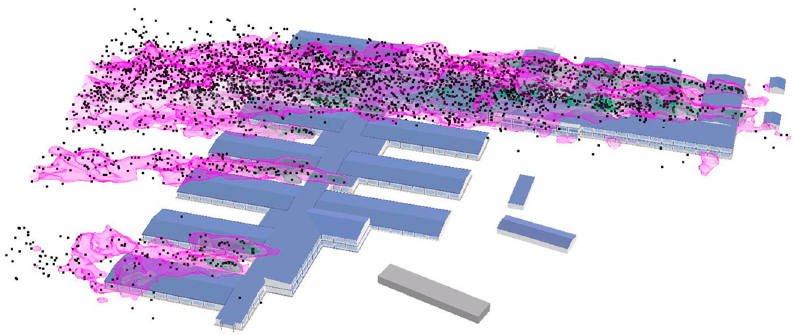
Figure 6. Visualization of the dispersive harmful air and concentration isosurface.